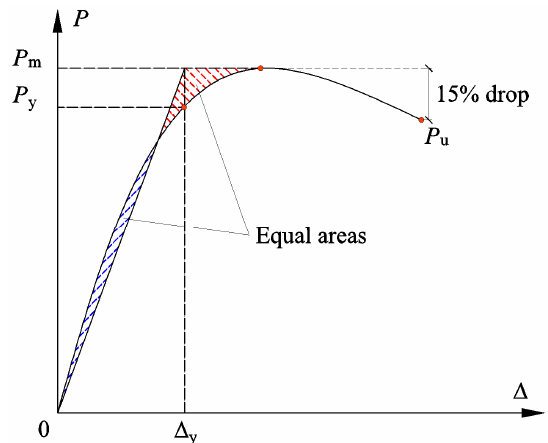
Figure 8. Illustration of energy equivalence method.